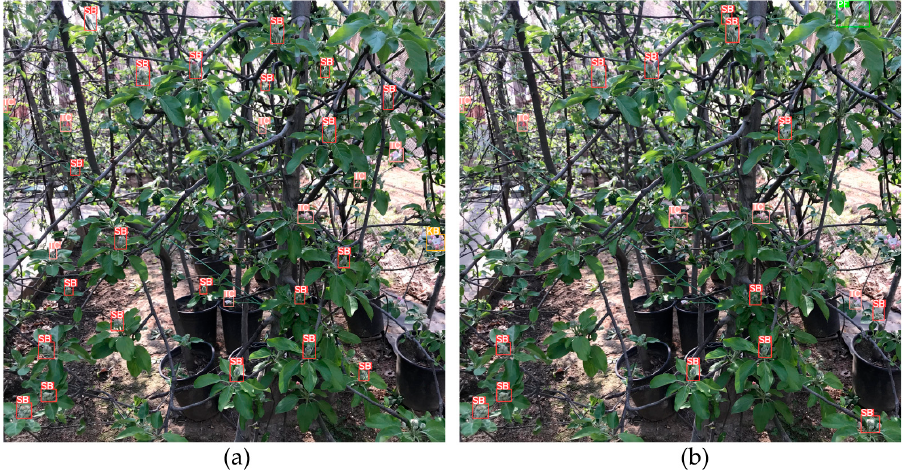
Figure 14. Comparison of the improved model in this paper and the YOLOv5s model for the detection of apple flowers at the ‘Spitting Buds’ stage. ( a ) Our model; ( b ) YOLOv5s.